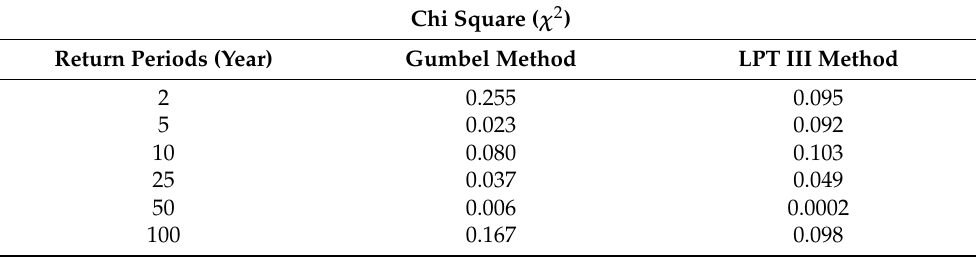
Table 5. The results of the chi-square goodness-of-fit test on the annual maximum